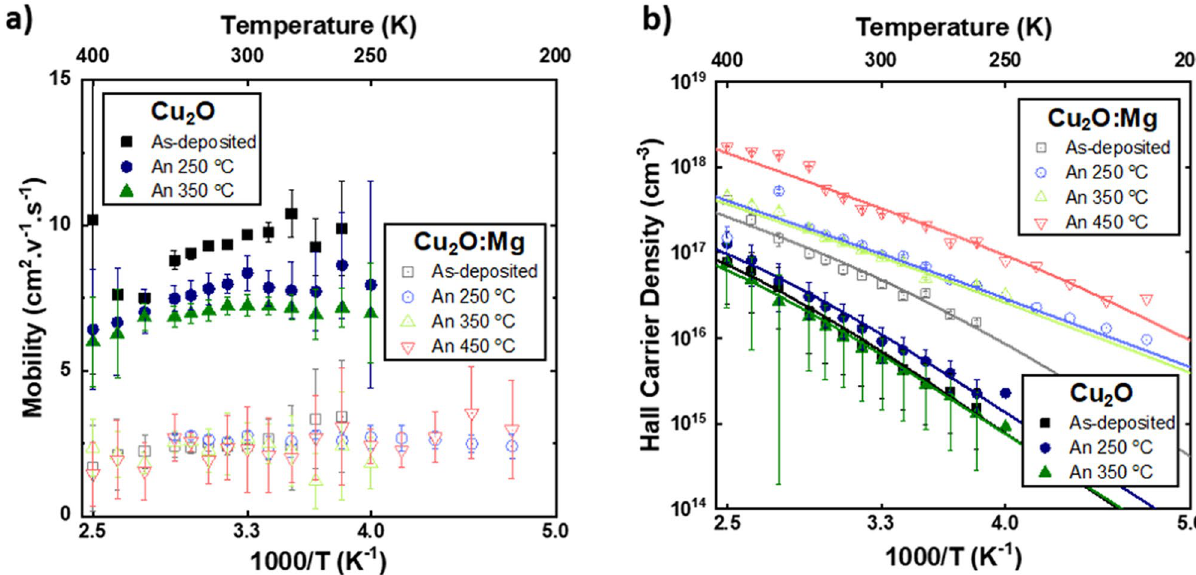
Figure 4. Temperature-dependent Hall effect measurements of Cu 2 O and Cu 2 O:Mg thin films. ( a ) Mobility (μ) and ( b ) Hall carrier density (p) as a function of the reciprocal temperature, where the lines correspond to the charge balance equation